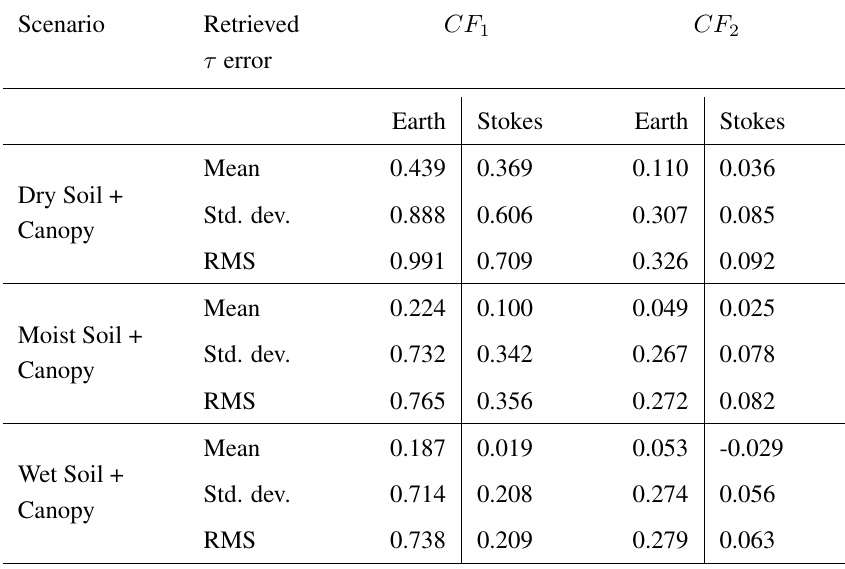
Table 5. Retrieved mean, standard deviation and root mean square vegetation opacity error of simulated SMOS observations over the vegetation-covered scenarios on Table 1, using the cost function configurations of Table 2, formulated on the Earth reference frame or using the first Stokes